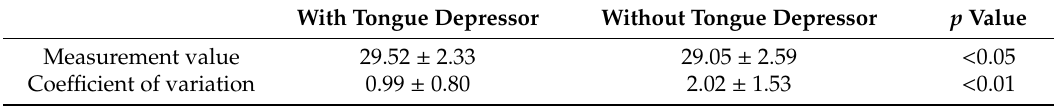
Table1. Meanvalueandstandarddeviationoflingualmucosalmoisturewithandwithouttonguedepressor. Table 1. Mean value and standard deviation of lingual mucosal moisture with and without tongue depressor. With Tongue